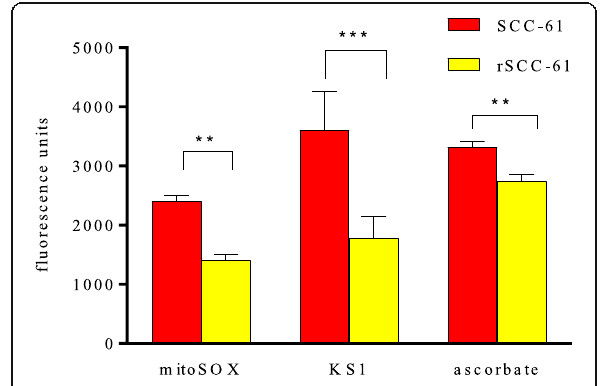
Fig. 2 Fluorescence MitoSOX assay of KS1 in two differentially ROS-expressing HNSCC cell lines (SCC-61 and rSCC-61). MitoSOX was the control, and ascorbate was the standard. The data was expressed as measured fluorescence units, with ** p ≤ 0.05 and *** p ≤ 0.005 considered statistically significant ( n = 6)